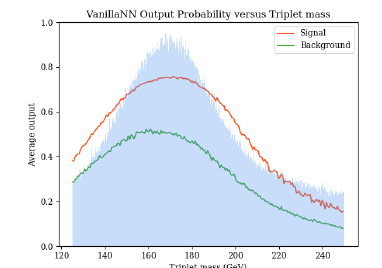
Figure 8. Average VNN output plotted against triplet mass. Blue histogram shows raw triplet mass distribution.